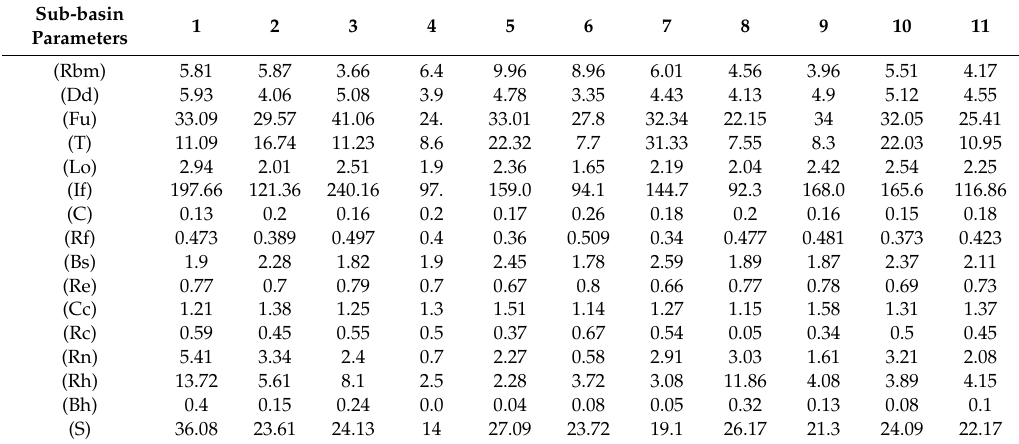
Table 5. Shape, linear and relief geomorphometric parameters of the Kalv¯ar¯ı